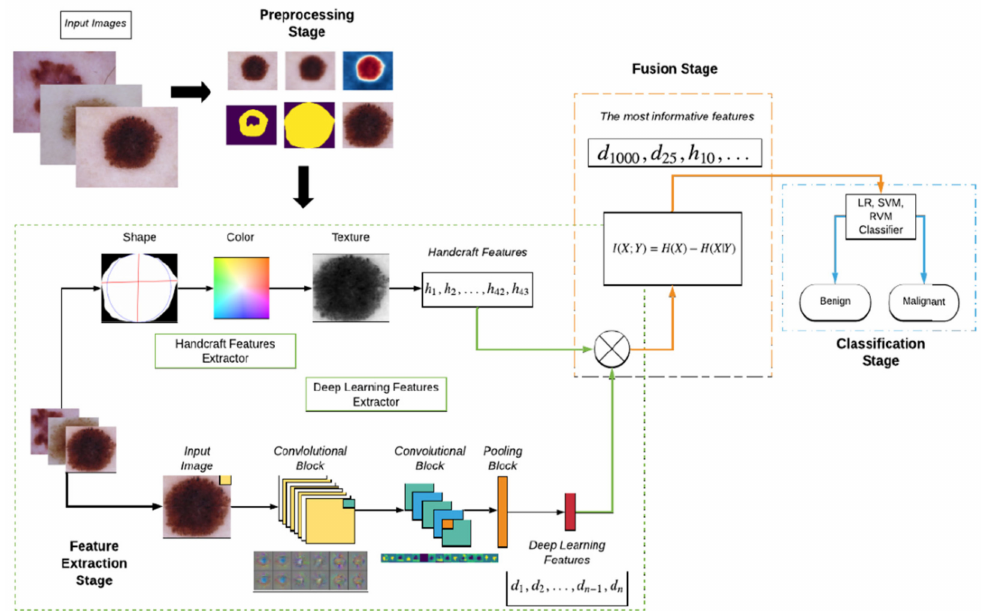
Figure 30. The architecture of the SL classification system proposed in